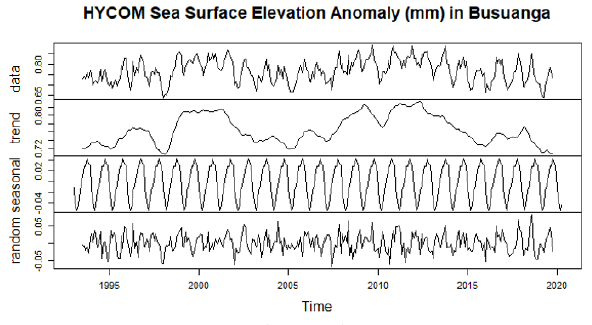
Figure 6. Decomposition of sea surface elevation anomaly in Busuanga from HYCOM